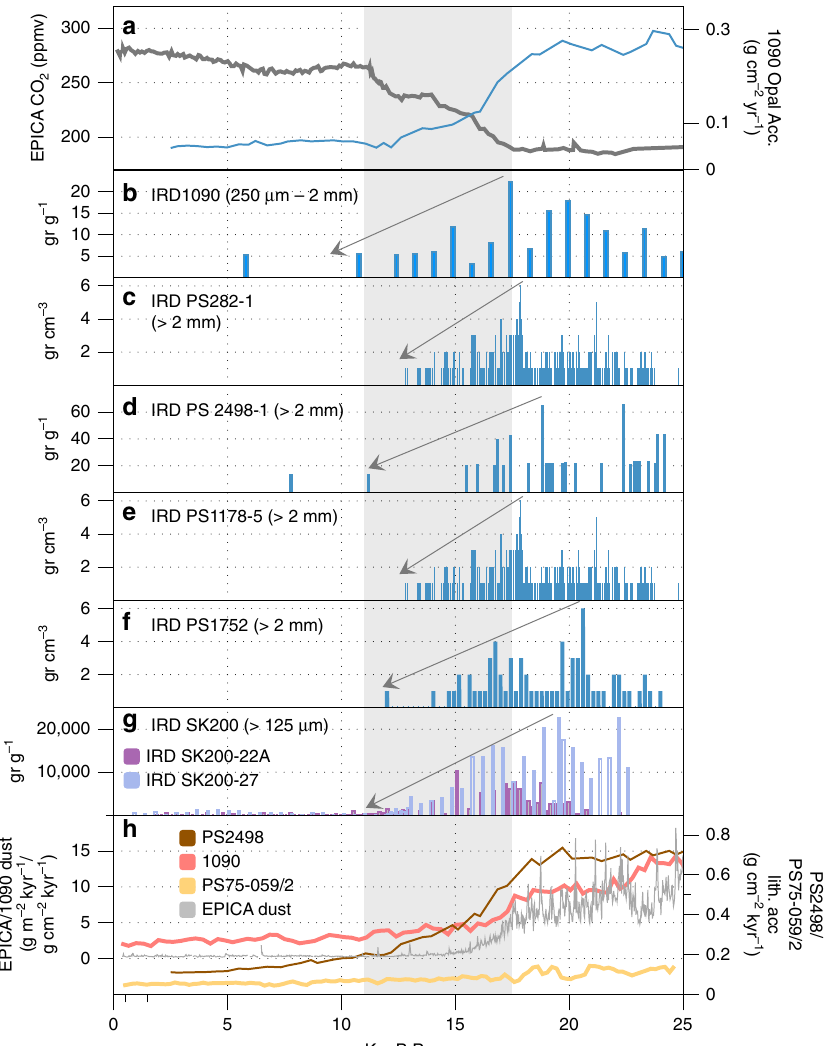
Fig. 5 Temporal variability in the Southern Ocean. Temporal variation in atmospheric CO 2 , marine opal accumulation, Ice-rafted debris (IRD) and total lithogenic inputs to the Southern Ocean over the past 25 ka: a atmospheric CO 2 concentrations (EPICA Dome C, dark grey line) and opal accumulation in sub-Antarctic cores 1090/PS2498-1174 (blue line) 151 , ( b ) IRD in core 1090 159 , ( c ) IRD in core PS282-1 where the IRD data are from ref. 160 and the Depth/ Age model is from Ref. 175 , ( d ) IRD in core PS2498-1 where the IRD data are from ref. 160 and the Depth/Age model is from ref. 151 , ( e ) IRD core PS1778-5, where the IRD data are from ref. 160 and the Depth/Age model is from ref. 176 , ( f ), IRD in core PS1752, where the IRD data are from ref. 160 and the Depth/ Age model is from ref. 177 . g IRD in cores SK200-22A and SK200-27 from the Indian Ocean sector of the Southern Ocean 161 . h Lithogenic fl uxes to the Southern Ocean for marine cores 1090 137 , PS2498-1 151 and PS75-059/2 152 alongside the EPICA Dome C dust fl ux record. The shaded area indicates the period of maximum CO 2 increase during deglaciation. See Supplementary Fig. 3 for core